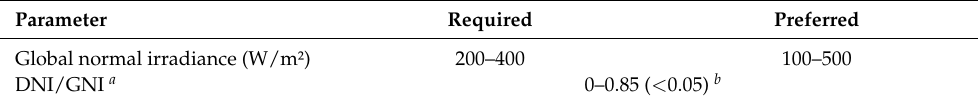
Table A2. Parameters required for qualifying a measurement as referring to a cloudy sky day [47]. Parameter